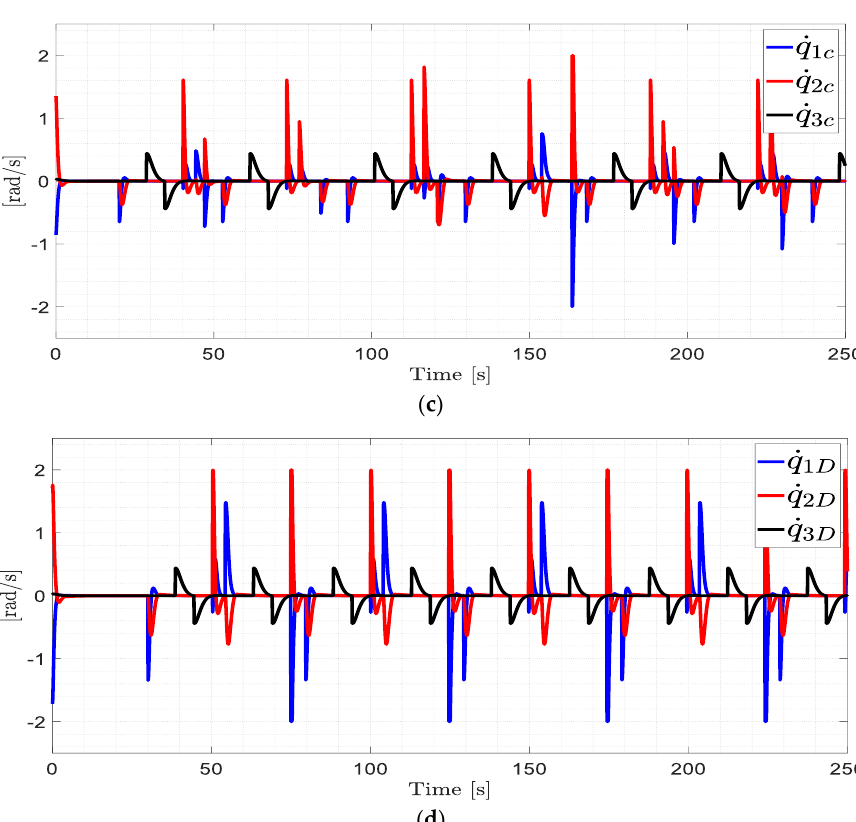
Figure 13. Movements of the Scara B robot in the virtualized industrial environment, when perform- ing the bottle selection task; ( a ) Desired and real robot operating end positions; ( b ) Distance between the desired positions and the real position of the robot ρ B ( t ) < (cid:107) velocities; ( d ) Maneuverability velocities calculated by the dynamic compensator.